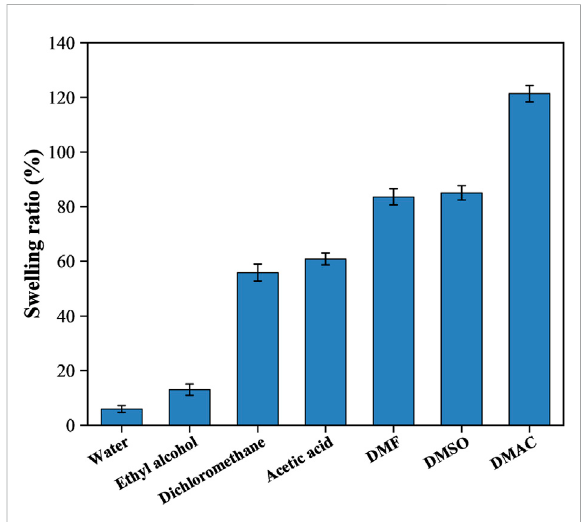
FIGURE 2 Swelling behavior of CFRP invarious solvents at120 ° C for 1 h.